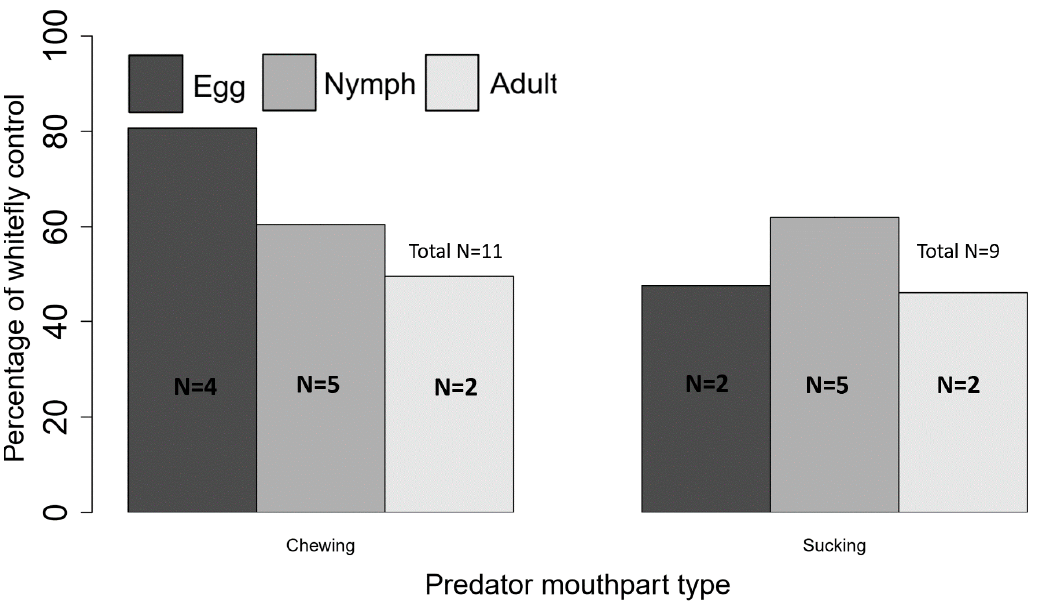
Figure 1. Contribution of generalist predators on stage-specific Bemisia tabaci control with chewing (11) and sucking mouthparts (9). The total number of studies used for calculation of the percentage of whitefly life stages control is indicated by “N” for each life stage and each mouthpart type. The percentage control was calculated by averaging the predation rate or percentage of whitefly population growth control across all studies.